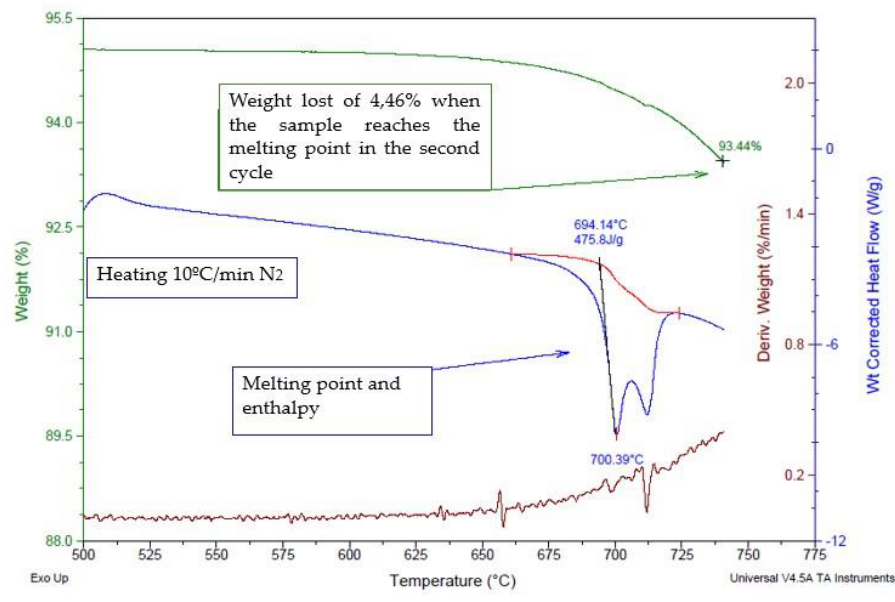
Figure 7. Second heating cycle in the DSC/TGA.